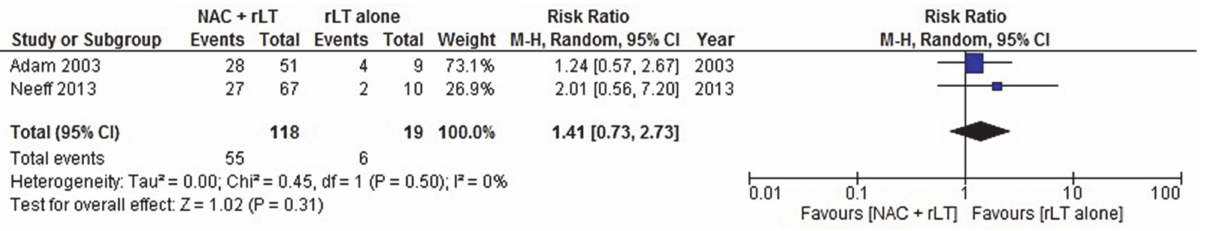
Figure 4. NAC + rLT versus rLT alone: three-year